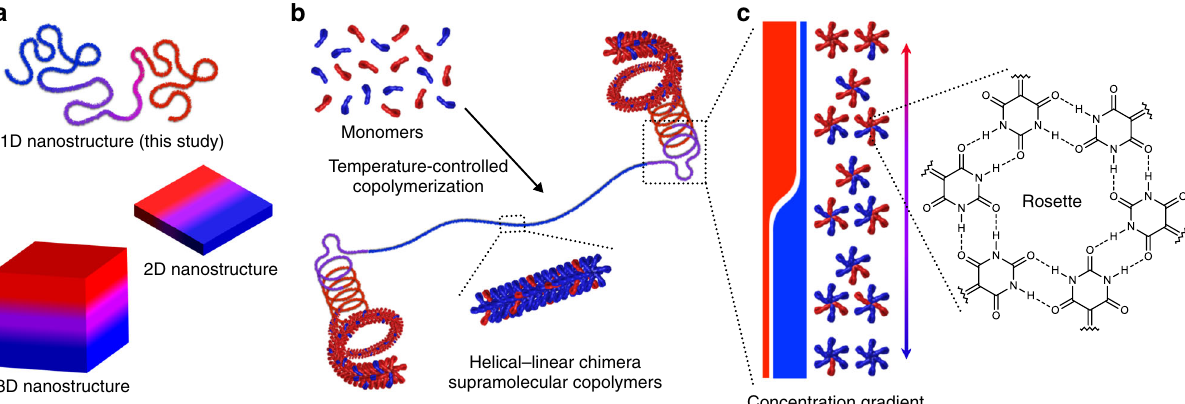
Fig. 1 Schematic illustration of supramolecular nano fi bers that are comprised of nanosegregated secondary-structure motifs. a Diagrams of 1D, 2D, and 3D nanomaterials with a concentration gradient of their constituent molecules. b Schematic representation of the spontaneous formation of supramolecular copolymers with helical – linear chimeric topology from a mixture of two essentially self-sorting monomers (colored in red and blue) via the formation of hydrogen-bonded supramolecular intermediates (rosettes). c Diagram of the internal concentration gradient of red and blue monomers, which enables alternation of the major components responsible for the distinct structural motifs during continuous growth of the supramolecular